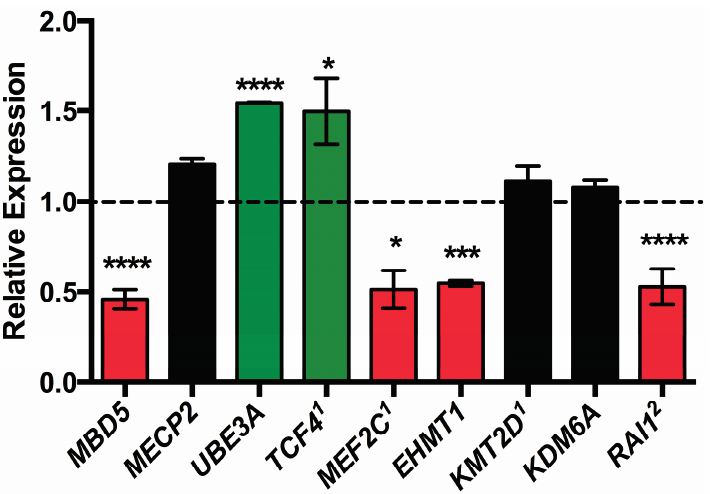
Figure 2. Dysregulation of associated genes in 2q23.1 deletion syndrome. MBD5 , MEF2C , EHTM1 , and RAI1 were significantly down regulated (red bars) while UBE3A and TCF4 were significantly up regulated (green bars). MECP2 , KMT2D , and KDM6A did not have altered mRNA levels (black bars). Gene expression is shown relative to control set to 1.0 (black line). Graphs represent mean ± SEM ( * p < 0.05, *** p < 0.01, **** p < 0.0001). 1 = Manuscript in review, 2 =